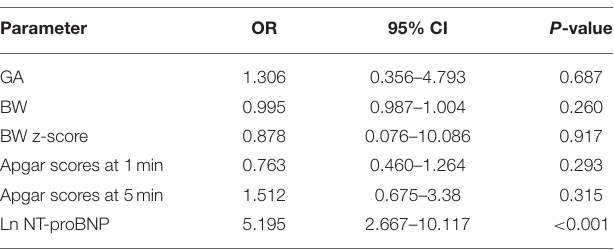
TABLE 3 | Results of logistic regression for BPD.